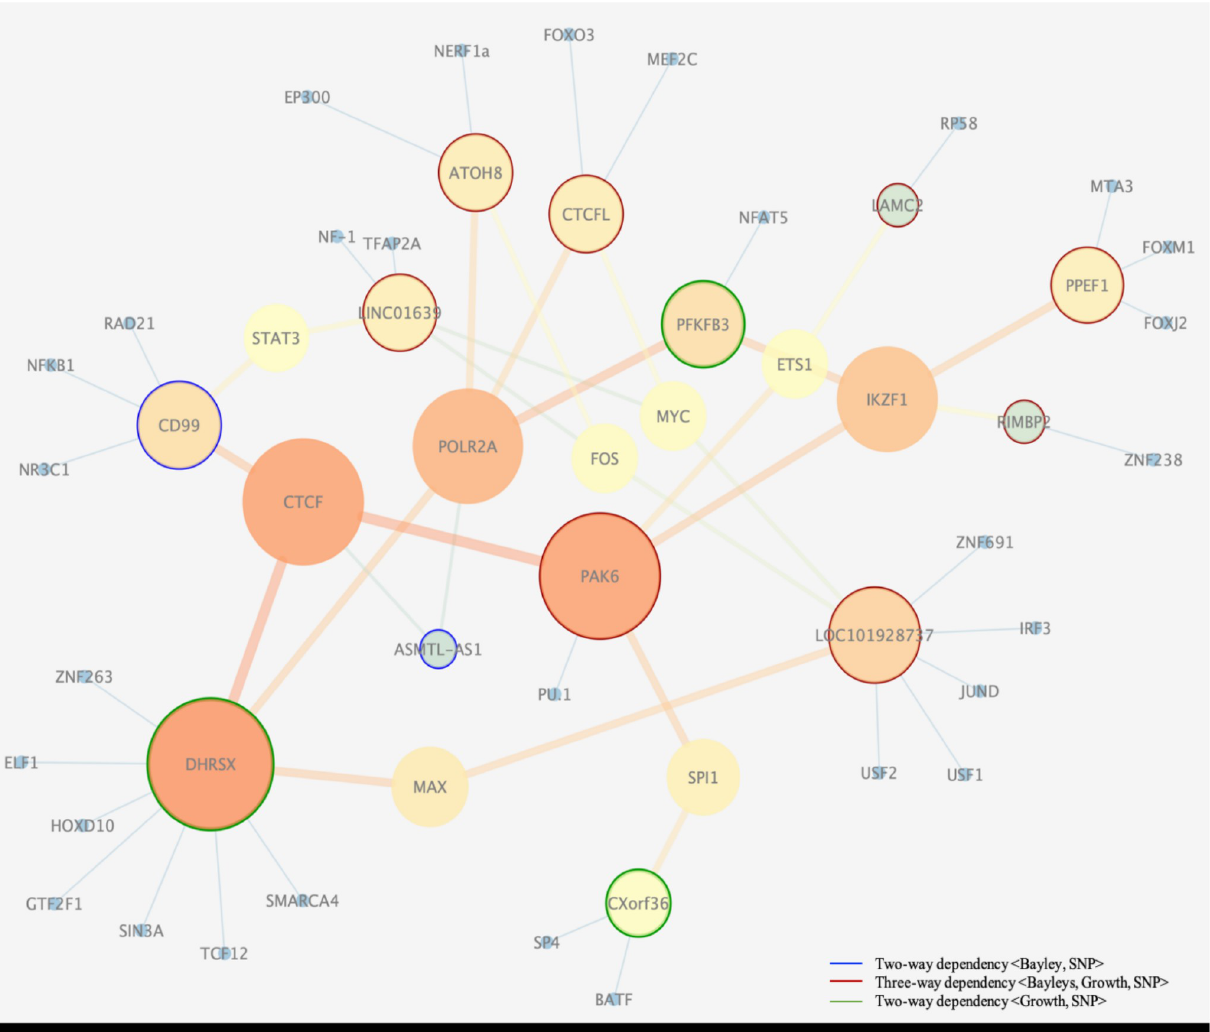
Fig 5. Regulatory interaction network. Depicted are interactions of transcription factors connected with regulatory SNPs (noted by their nearest gene). Clustering and visualization of the network was carried out using Cytoscape v.3.3.0 (undirected network and betweenness centrality statistics). The degree of nodes (the number of edges per node) is shown with their color, ranging from orange (the highest degree), to yellow, green, and then blue (the lowest degree). In addition, larger nodes correspond to hubs with higher degree. The edges with high betweenness centrality, whose removal would partition the network into connected subnetworks, are depicted by thick, orange lines. The small blue nodes are additional factors connected to the dependent loci. “Orphan genes” (unconnected nodes) are not shown. Nodes with blue, green, and red rings correspond to loci detected with two-way and three-way analysis (see the